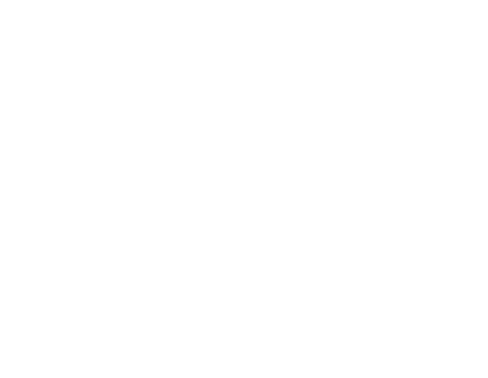
Figure 12. Changes of CAT activity of Agaricus bisporus in each packing group during storage.